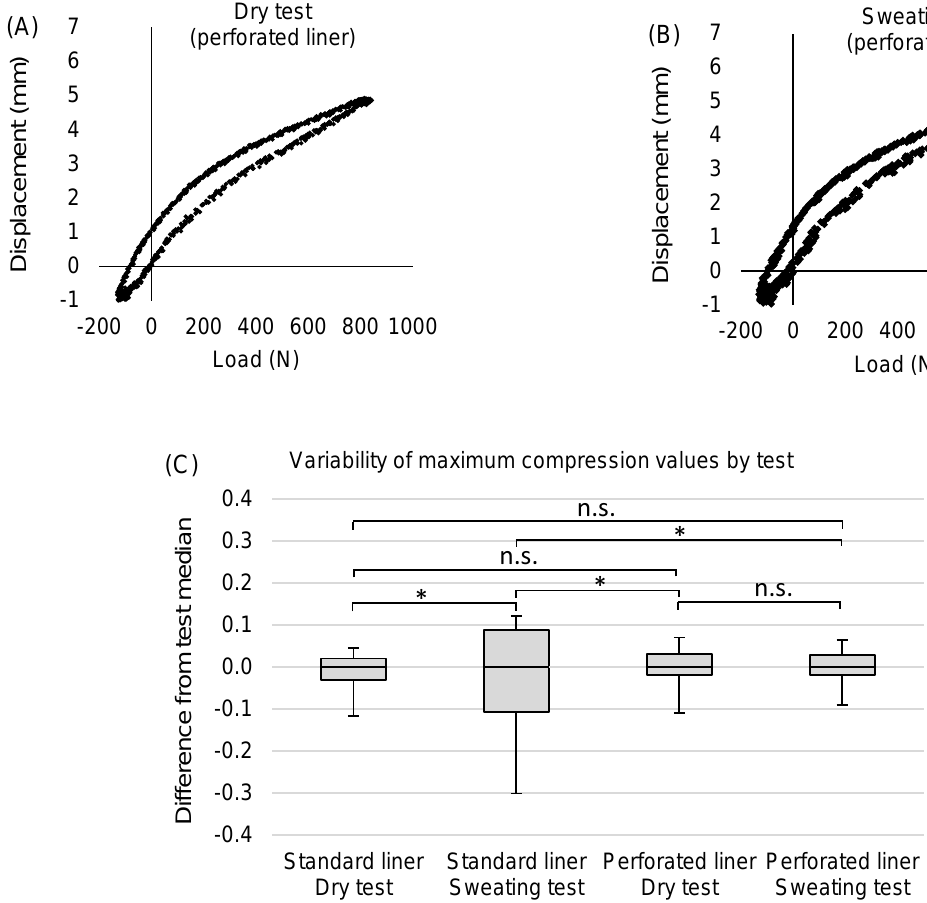
Figure 4: (A) The hysteresis curve of a dry test with the perforated liner (B) the hysteresis curve of a sweating test with the perforated liner (C) A box-and-whisker plot of the maximum displacement values from the dry and sweating tests with the standard and perforated liners (normalised by median). The box indicates the interquartile range and the whiskers indicate the maximum and minimum values. The lines at the top of the plot show where comparisons of variability were made. Asterisks (*) indicate a significant difference (p<0.05) in variance between tests.